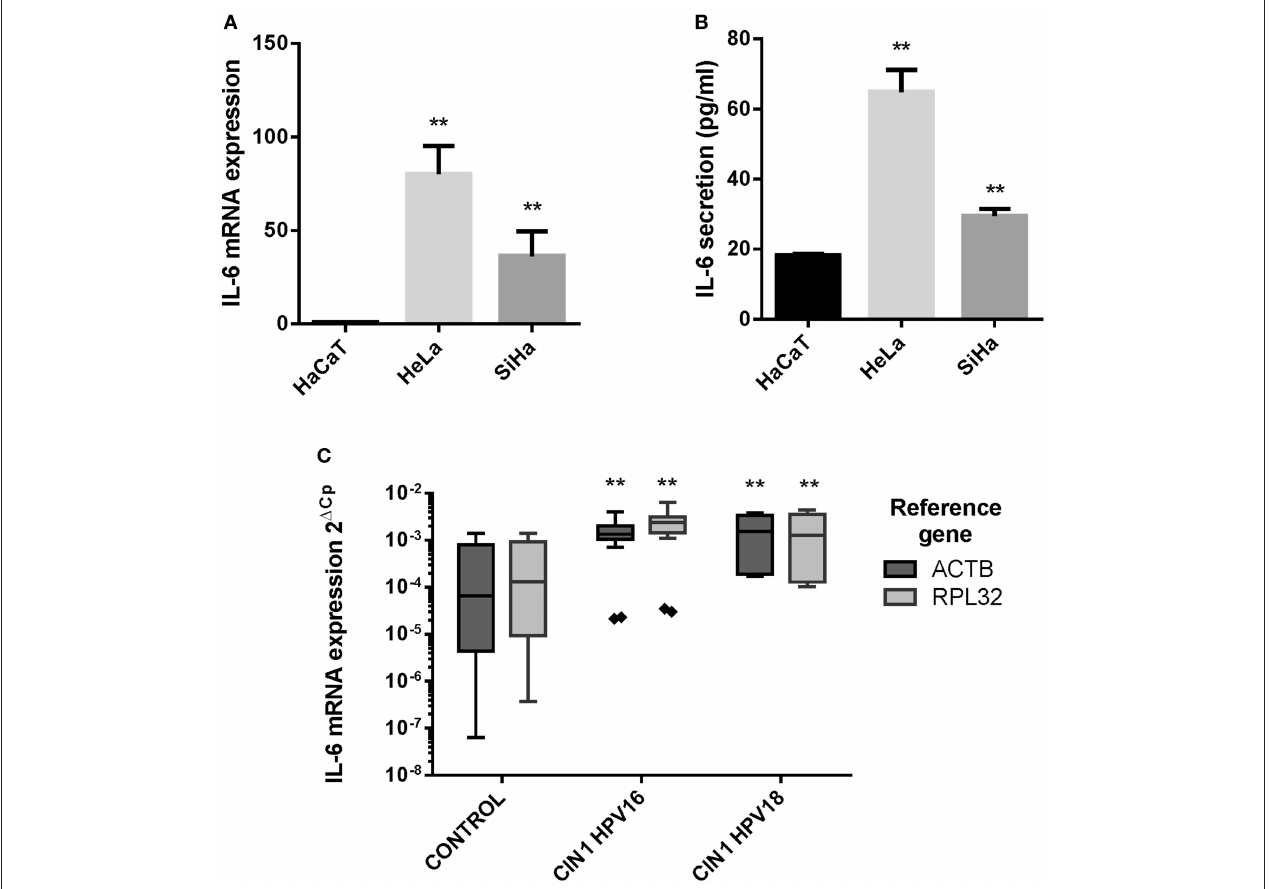
FIGURE 1 | IL-6 expression in HaCaT, HeLa, SiHa cells, and in cervical samples. (A) IL-6 mRNA relative expression in HaCaT, HeLa, and SiHa cell lines evaluated by qPCR using actin, RPLP0 and RPL32 as reference genes. (B) IL-6 protein expression measured by ELISA test in HaCaT, HeLa and SiHa supernatants. Error bars in (A,B) represent standard deviation. (C) IL-6 mRNA expression in 9 HPV negative cervical samples without lesion (Control), 7 HPV16 positive CIN1 cervical samples (CIN I HPV16) and 3 HPV18 positive CIN1 cervical samples (CIN I HPV18) using actin and RPL32 as reference genes. Values are represented as 2 1 Cp (Cp Reference Gene—Cp Target Gene). The graph displays median (white lines), 25–75th percentile (boxes), interquartile ranges (Whiskers) and outlier data (triangles). Asterisks indicate statistical significance (** p <